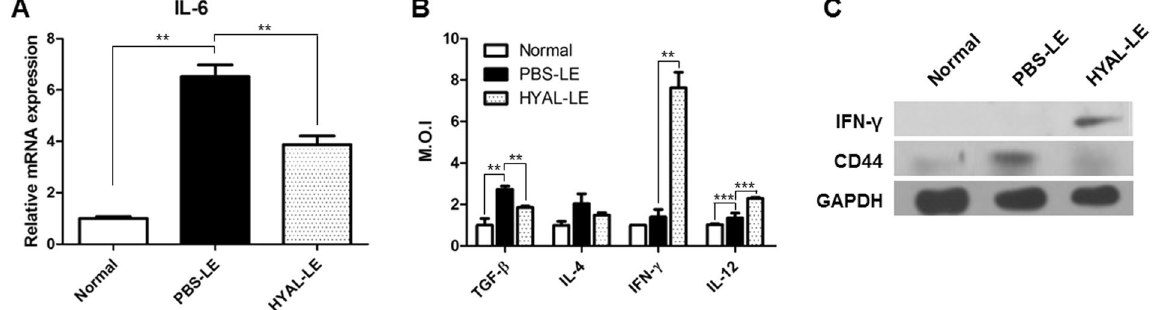
Figure 5. Subcutaneous hyaluronidase injection alters cytokine expression. Analysis of cytokine expression in total mouse leg tissue. ( A ) Quantitative real-time PCR analysis of IL-6 mRNA expression. Data are presented as means ± SEMs. ( B ) ELISA analysis of the levels of TGF- β , IL-4, IFN- γ , and IL-12. Data are expressed as median optical intensities. Data are presented as means ± SEMs. ( C ) Representative western blot of IFN- γ and CD44 expression. ** P < 0.01, *** P <